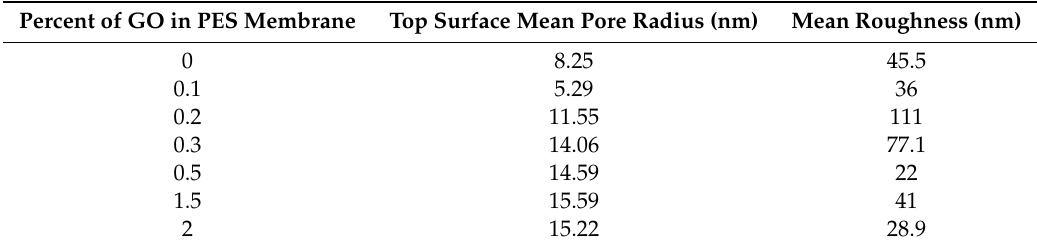
Table 2. Mean surface pore size and roughness for the top surface of the blend membranes. Percent of GO in PES Membrane